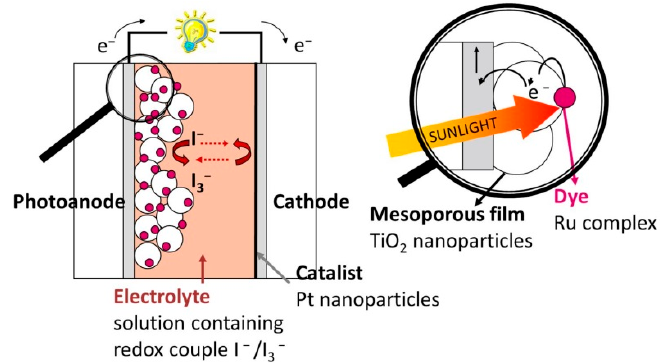
Figure 1. Schematics of a DSSC ( left ) and detail of the photoanode ( right ). A comprehensive review of the operating principles of a DSSC is reported in [20].